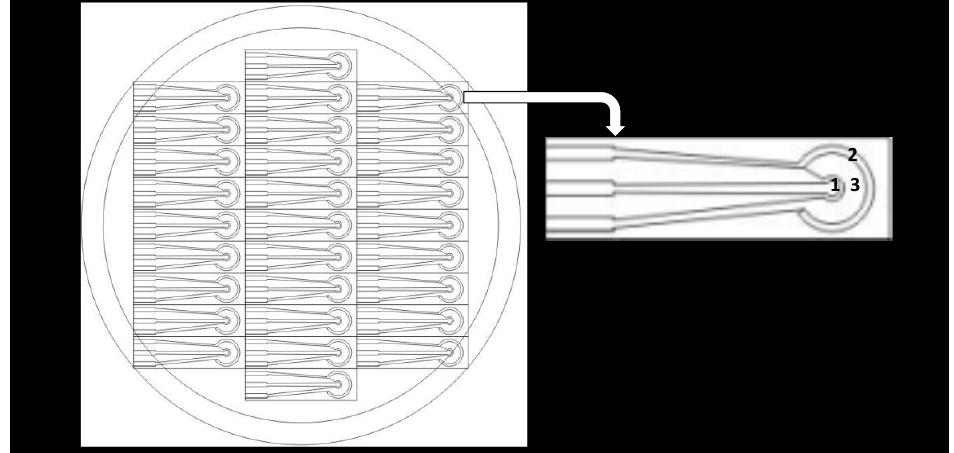
Figure 2. Scheme of a 4 inch silicon wafer covered with a polycrystalline BDD film (500 µm thick), micromachined using a femtosecond laser into 29 BDD microcells and of one BDD microcell including the working electrode (1), the counter electrode (2), and the pseudo reference electrode (3). Copyrights from Elsevier [39].